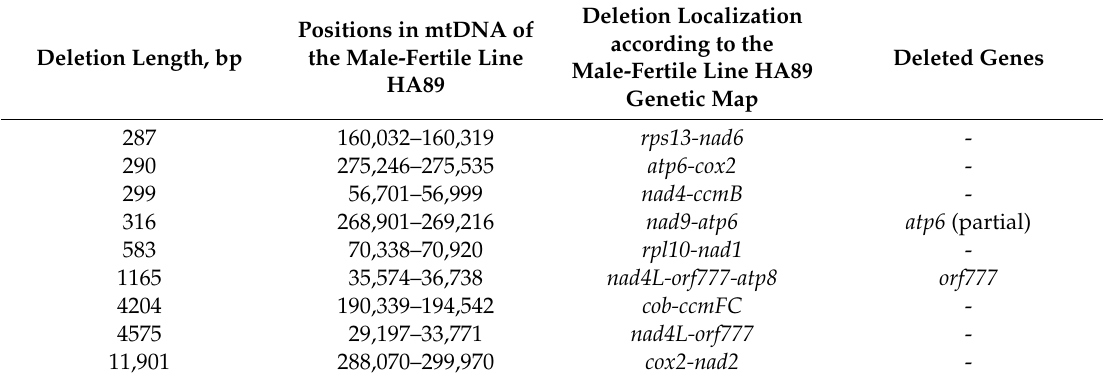
Table 2. Deletions ( > 100 bp) localized in the mitochondrial genome of HA89(ANN2) CMS line.